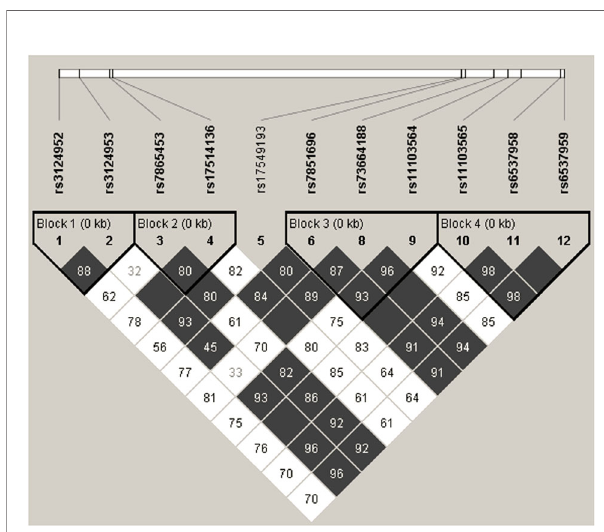
FIGURE 1 | Linkage disequilibrium analysis of promoter [rs3124952 (-986); rs3124953 (-602); rs7865453 (-64); rs17514136 (-4)], exon 8 [rs17549193 (+6359); rs7851696 (+6424)] SNP and polymorphisms identi fi ed in this study (rs73664188; rs11103564; rs11103565; rs6537958; rs6537959). The numbers in the grid refer to D ’ parameter (presented as percent) of the given pairs of SNPs. Empty grey squares represent perfect LD (D ’ =1). SNP identi fi ers are indicated on the abscissas. Bolded triangles shows haplotype blocks identi fi ed using Four Gamete Rule test.